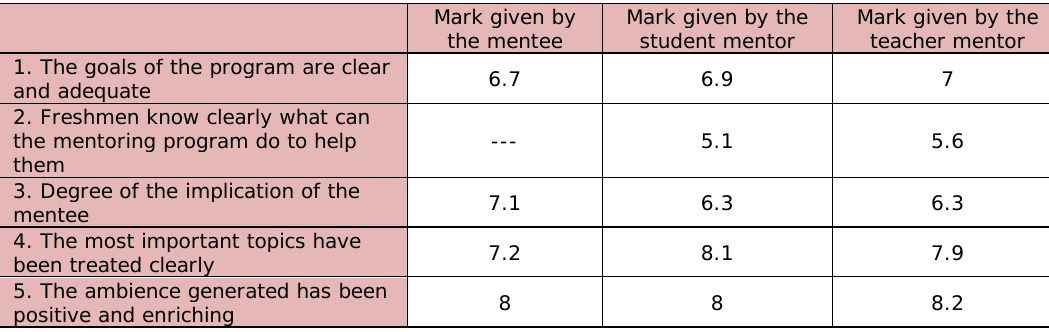
Table 2. “Agreement rate with the development of the PATU